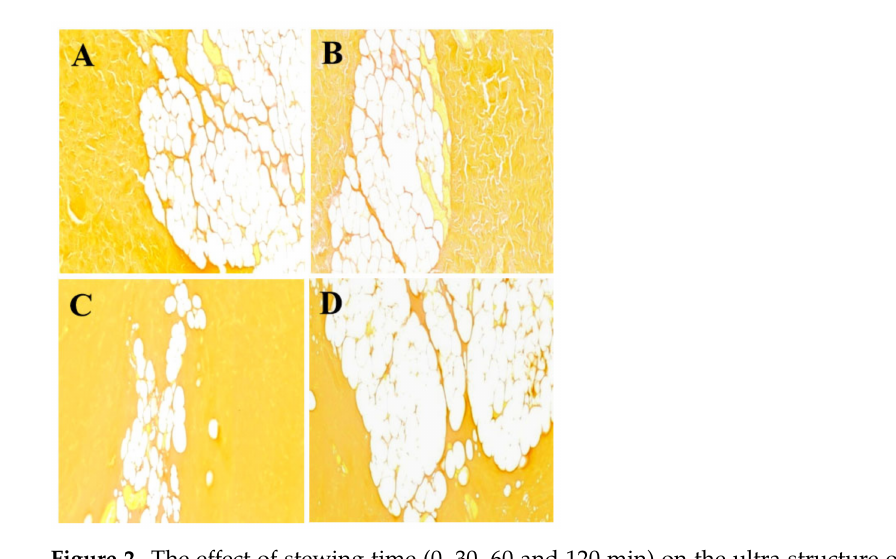
Figure 2. The effect of stewing time (0, 30, 60 and 120 min) on the ultra structure of fat globules. ( A – D ) represents samples at 0, 30, 60 and 120 min, respectively; magnification × 100.